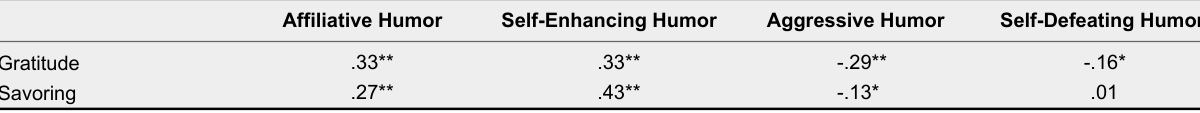
Correlations Between the Four Humor Styles, and Gratitude and Savoring